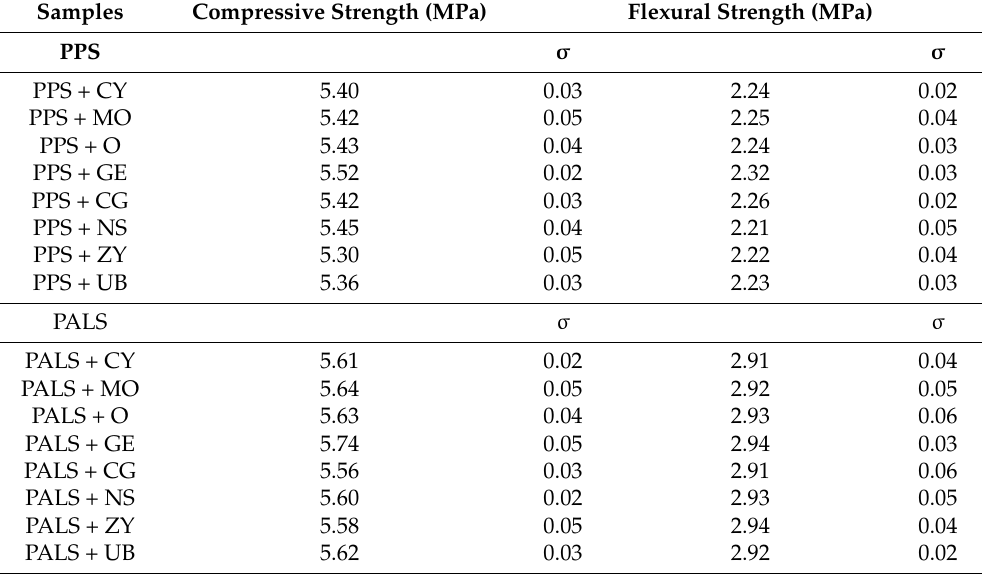
Table 7. Results for mechanical tests and standard deviation for the different pastes containing added pigments tested after 120